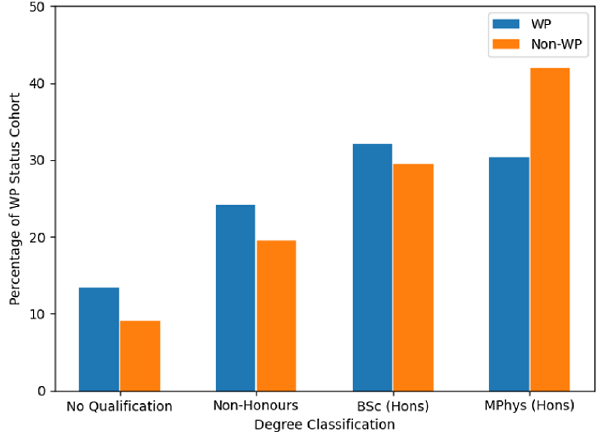
FIG. 5. Percentage of cohort exiting with each qualification type, disaggregated by WP status ( N ¼ 322 , WP ¼ 112 , non- WP ¼ 210 ). CertHE, DipHE, and BSc (Ord) have been grouped as Non-honor ’ s due to low numbers.